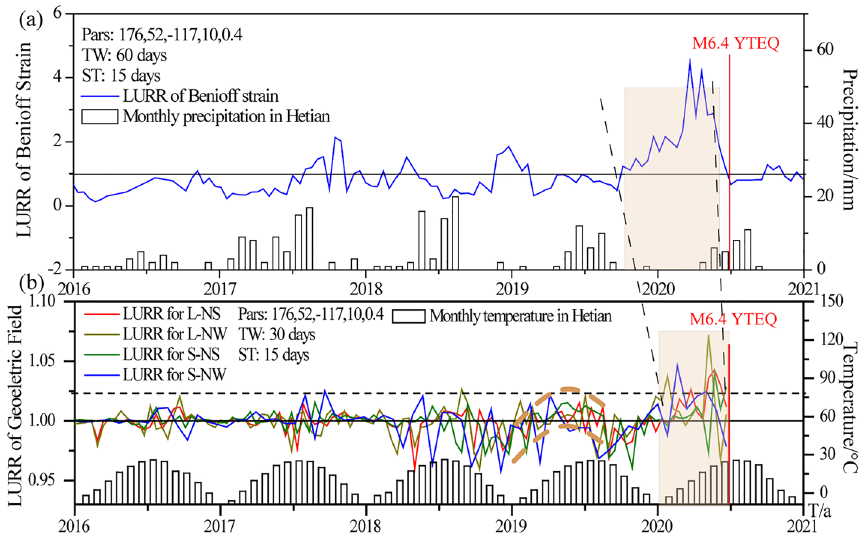
Figure 5. LURR time series curve for Benioff strain ( a ) and geo-electric field ( b ) before the Yutian earthquake. Par is the mechanism of the main shock used for the Coulomb rupture stress calculation, which is: strike, dip, slip, depth, and friction coefficient; TW is the calculation time window; ST is the sliding time window; the red vertical line is the magnitude and time of the Yutian earthquake; the black dashed line indicates the start and end times of anomalous LURR before the occurrence of the Yutian earthquake; the parallel black dotted line is the threshold line of the anomalous LURR. The precipitation and temperature in the Yutian are also shown in the maps. The synchronous changes in early 2019 are highlighted in the maps by brown arc. The unit of the horizontal axis is time, and the ‘t/a’ means